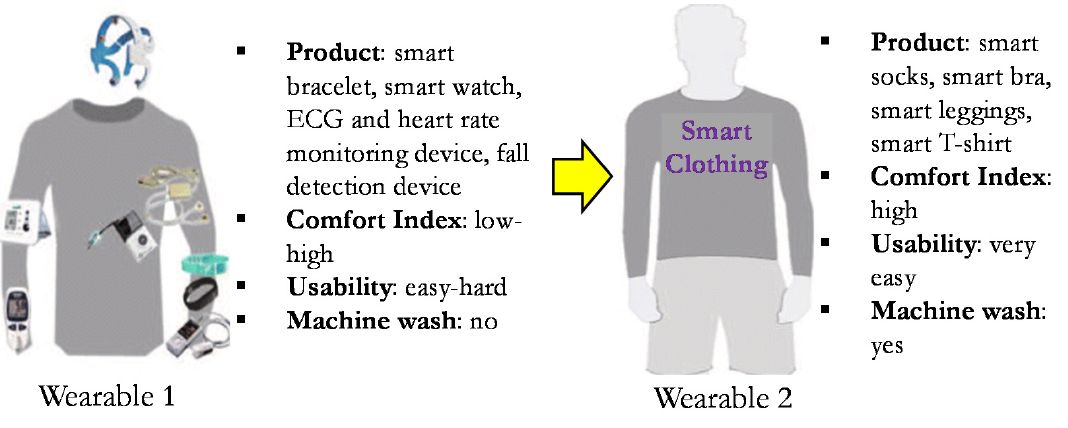
Figure 5. Comparison between traditional wearable system and smart clothing (adapted from [9]).